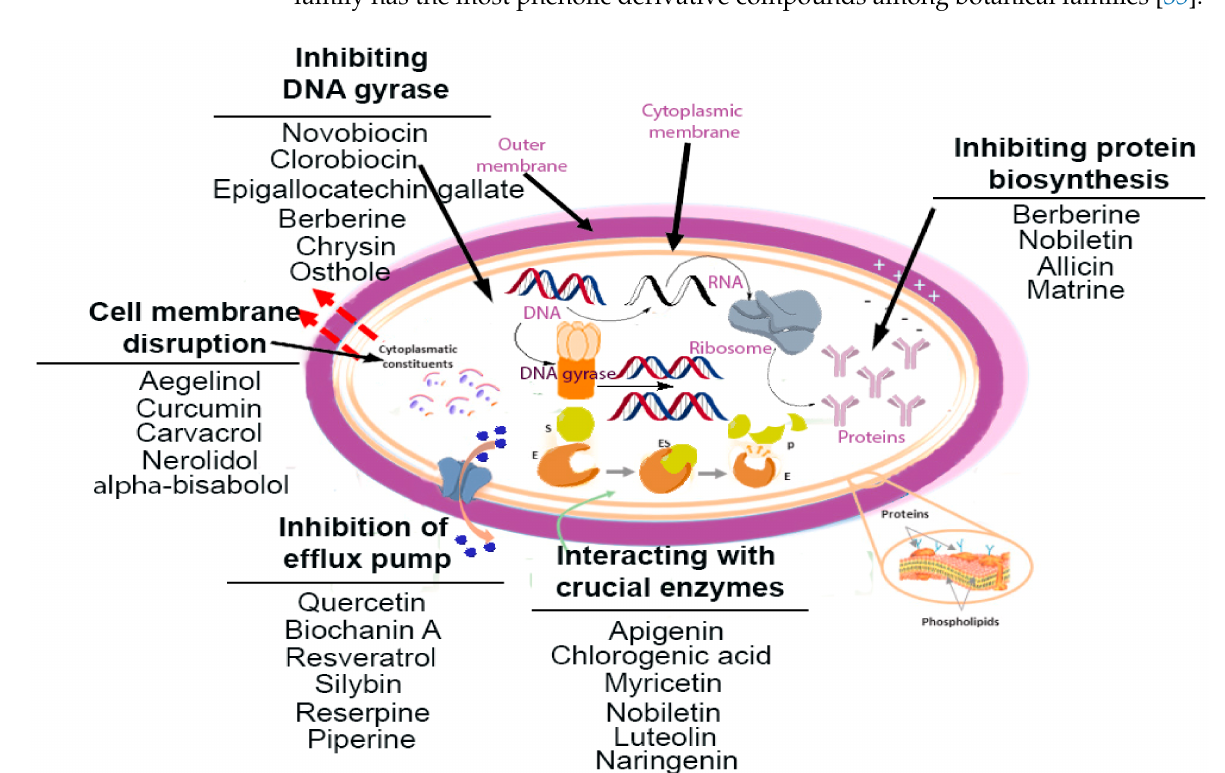
Figure 1. Antibacterial mechanism of action of plant-derivative